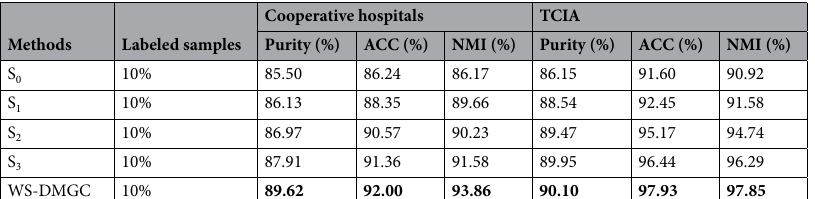
Methods Labeled